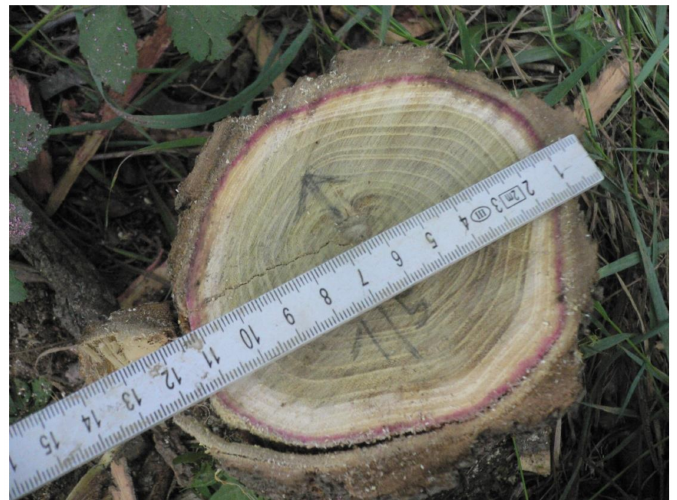
Figure 4. Dye-stained area of the sample tree. The dye penetrated only the outermost growth ring. This area represents the hydrologically active sapwood.